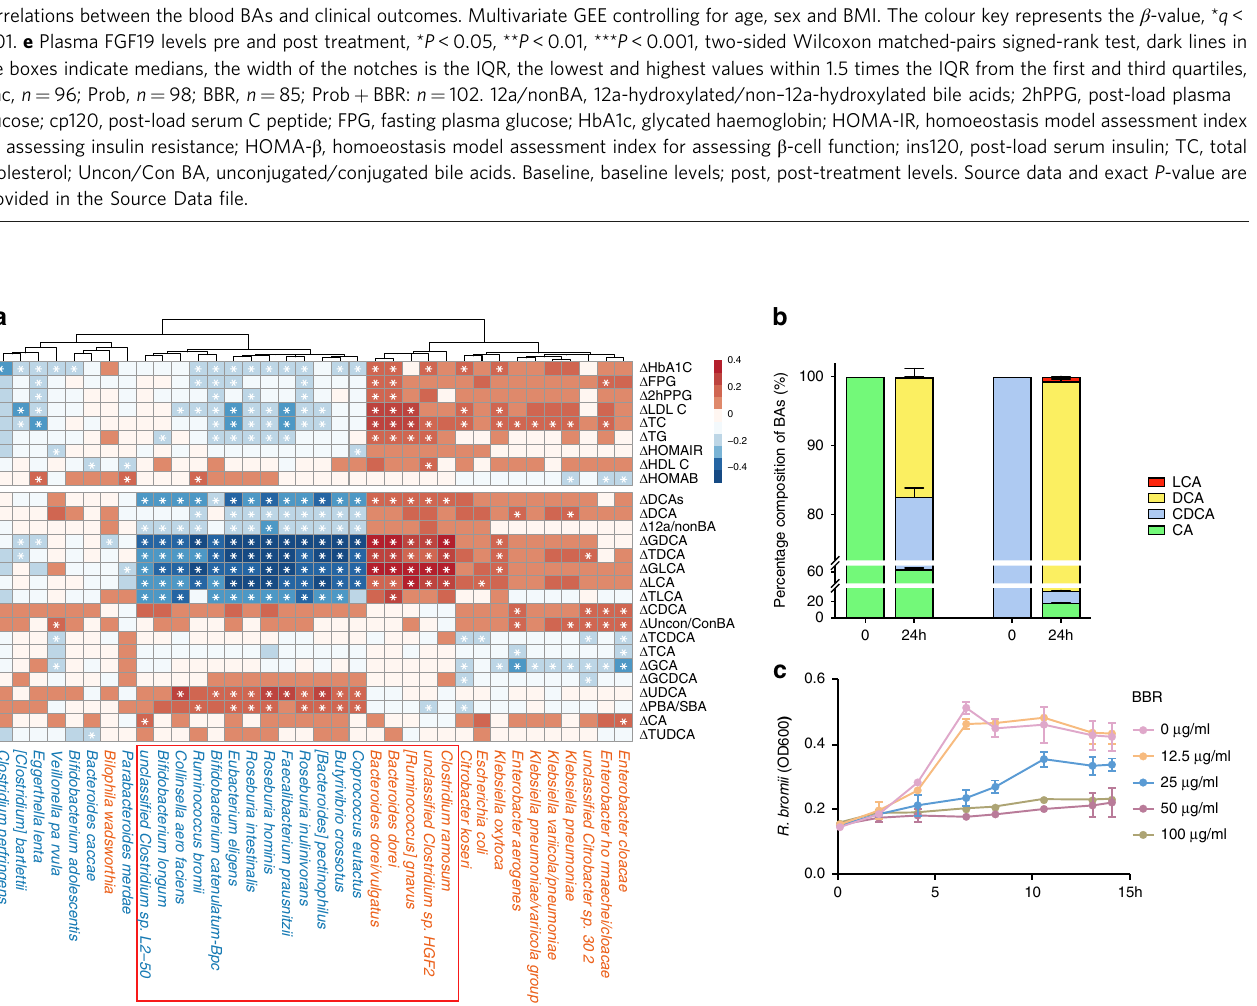
development of ageing-related diseases 53 . BBR suppressed multiple Bi fi dobacterium spp. either in the human participants in our study or in rodents 31,54 . Health-associated Bi fi dobacterium spp. have been shown to be depleted along with ageing but enriched in extremely aged healthy subjects 34 . Thus, our probiotics formula containing